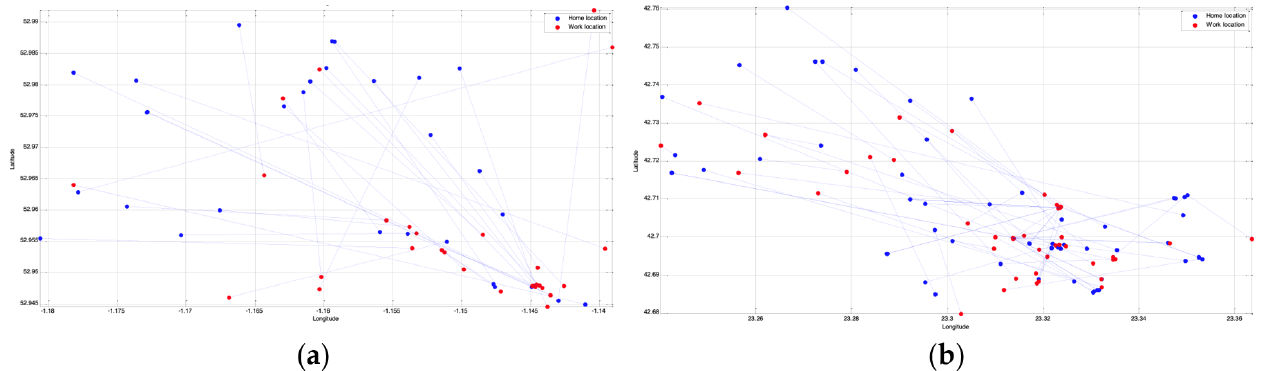
Figure 18. From-to locations of our trial commuters in ( a ) Nottingham (left) and ( b ) Sofia